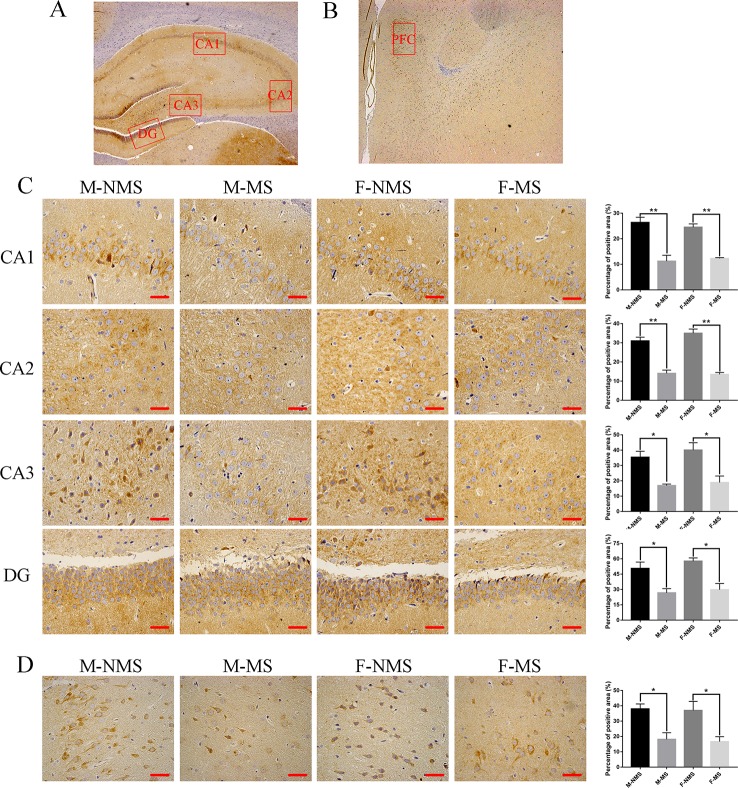
MS reduces SYN protein expression in immunohistochemistry. (A) Schematic of the coronal section from rat hippocampus and the locations of CA1, CA2, CA3, and DG regions. (B) The red frame area indicates the field of view of the prefrontal cortex. (C) Representative 400× photomicrographs of SYN protein expression of the CA1, CA2, CA3, and DG regions of the hippocampus. Results of the percentage of SYN-positive area in the hippocampal CA1, CA2, CA3, and DG regions are statistically significant. (D) Representative 400× photomicrographs of SYN protein expression in the prefrontal cortex. Statistical results of the percentage of SYN-positive area in the prefrontal cortex. Statistical analyses are performed by two-way ANOVA followed by t-test. Data are presented as mean ± SEM, *p < 0.05, **p < 0.01, n = 3 per group, scale bar = 50 µm.